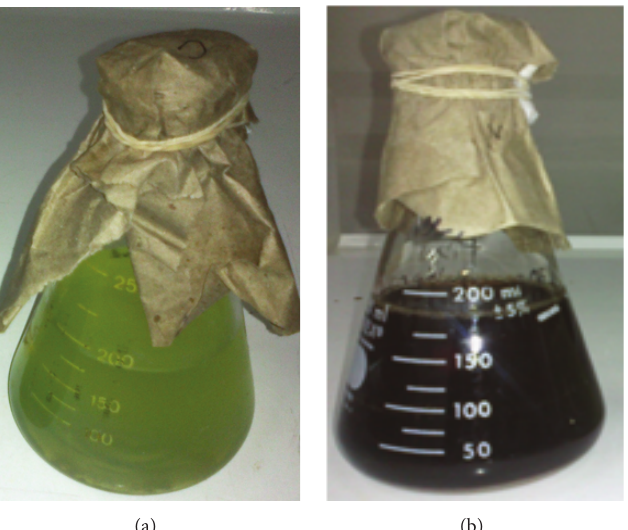
Figure 1: Biosynthesis of Ag-NPs. (a) Culture supernatant of P. aeruginosa without Ag + ions after 24 h of incubation. (b) Culture supernatant of P. aeruginosa with AgNO 3 10mM after 24 h of